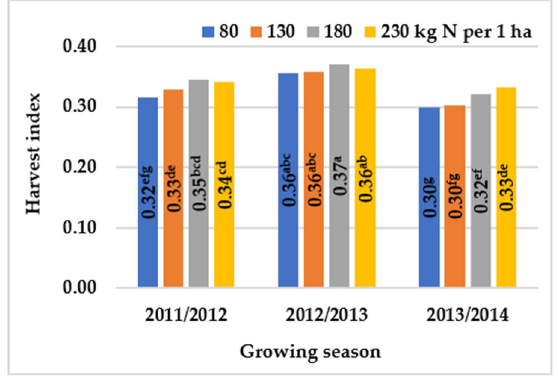
Figure 7. The effect of N rate on the straw yield of winter oilseed rape, across growing seasons (2011–2014). Means with the same letters do not differ significantly at p ≤ 0.05 in Tukey`s test.